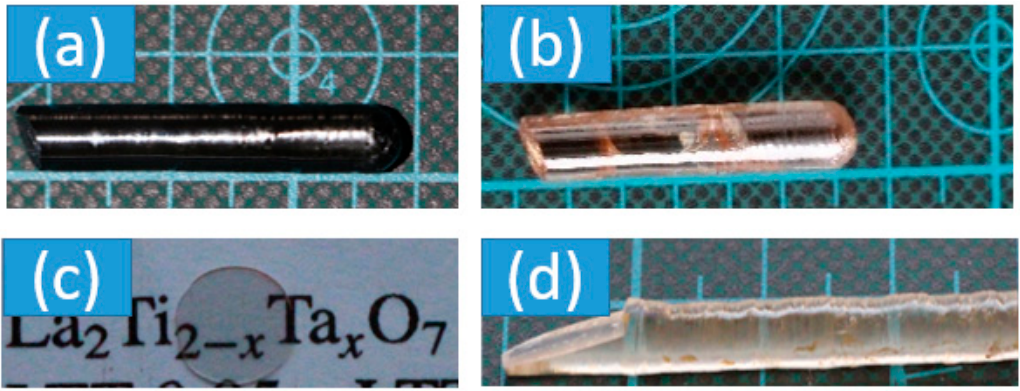
Figure 1. Ta-LTO single crystal grown by spontaneous nucleation with optical floating zone method ( a ) Ta-LTO single crystal was annealed for 1 h at 1200 °C; ( b ) Ta-LTO crystal wafer after annealing; ( c ) LTO single crystal by floating zone method ( d ).